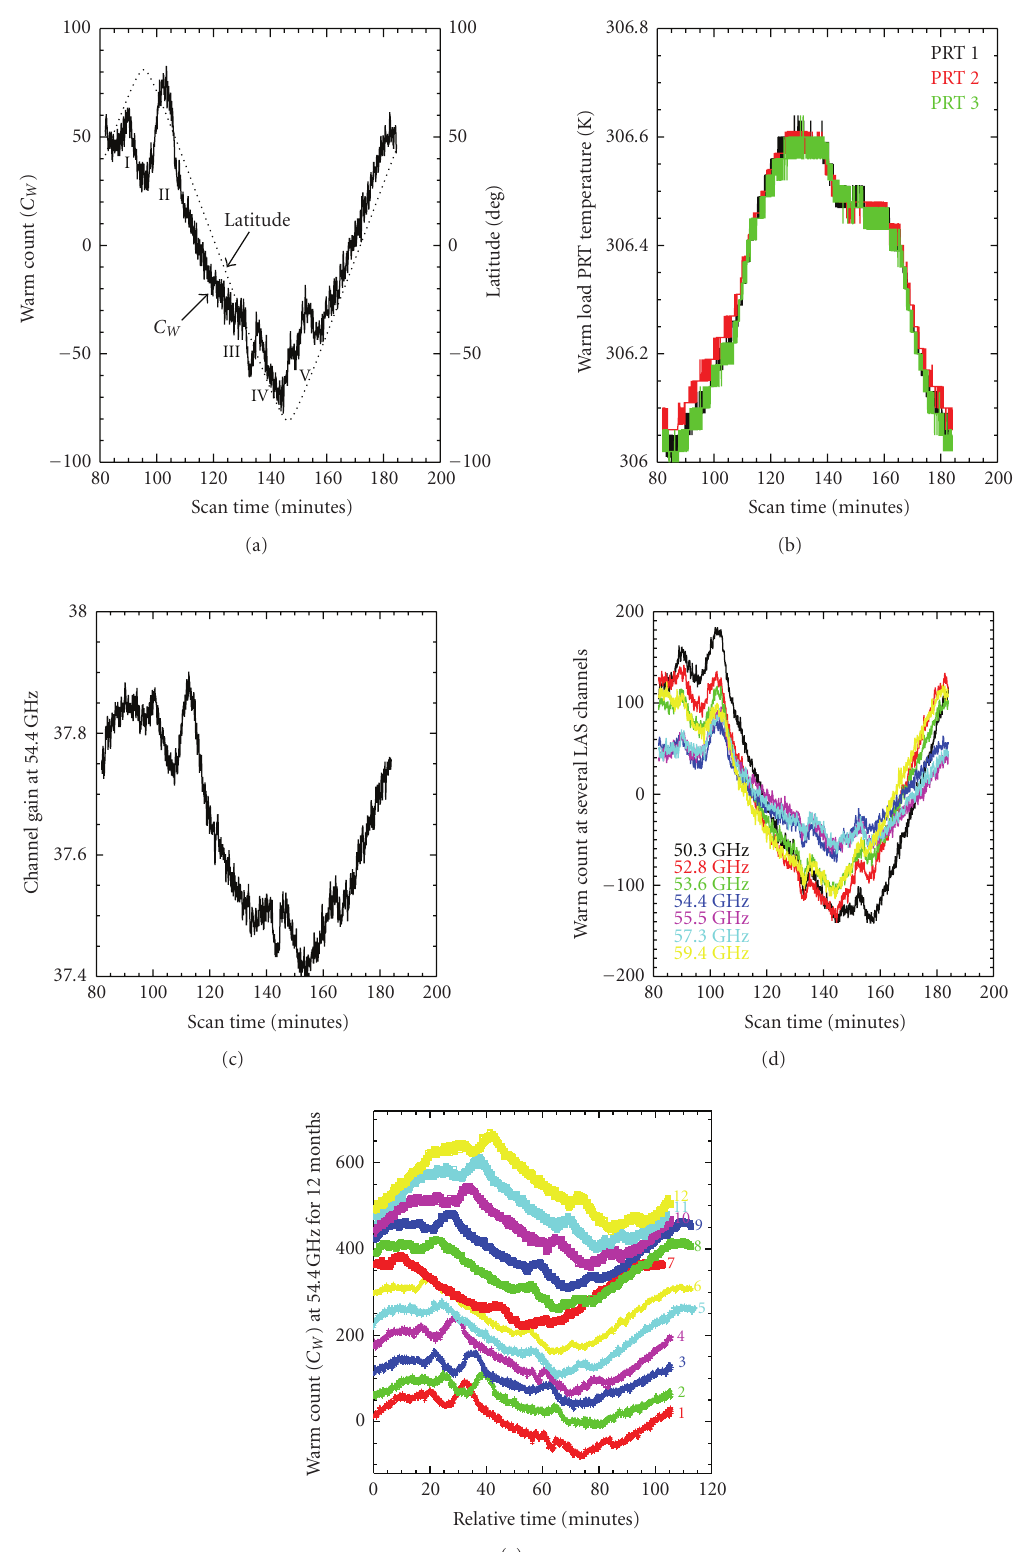
Figure 3: Time series of C W , T W , gain, during one orbit of observations, on March 20, 2005 for (a) ∼ (d) and on the first day of twelve months 2005 for (e), where a constant (orbital mean of corresponding counts) has been subtracted from the warm count to emphasize characteristics of warm count anomaly. (a) C W at 54.4GHz. (b) T W . (c) gain at 54.4GHz. (d) C W at 50.3, 52.8, 53.6, 54.4, 55.5, 57.3, 59.4GHz. (e) Time series of C W at 54.4 GHz during one orbit in twelve months in 2005, where the numbers from 1 to 12 denote the month of